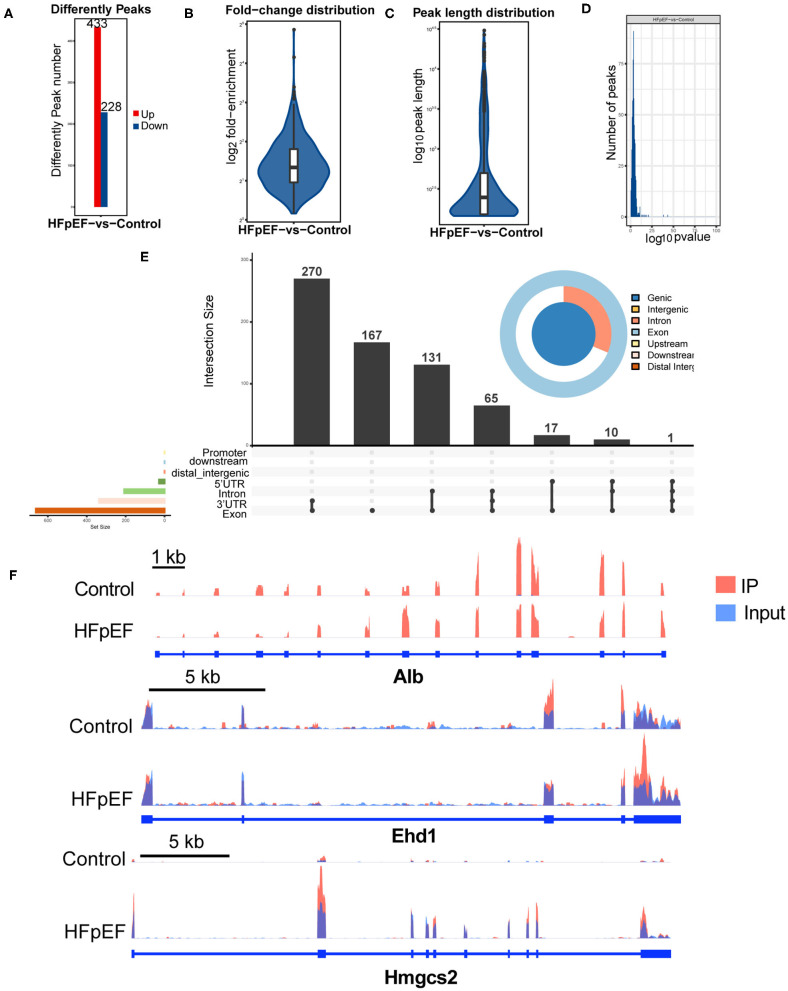
The difference analysis of identified m6A peaks in HFpEF mice and control mice. (A) The up-regulated and down-regulated peak numbers in HFpEF mice, compared with control mice. (B–D) The fold-enrichment (B), length (C), and distribution of P-value (D) of altered m6A peaks. (E) The exact distribution pattern of significantly altered peaks in HFpEF mice. There were 270 peaks distributed in the 3′UTR and exon regions, 167 peaks in the exon region, and 131 peaks in the intron and exon regions. (F) Three representative genes with significantly changed peaks. The m6A levels of Alb, Ehd1, and Hmgcs2 were significantly up-regulated in HFpEF by 29, 8.34, and 3.27 times, respectively.